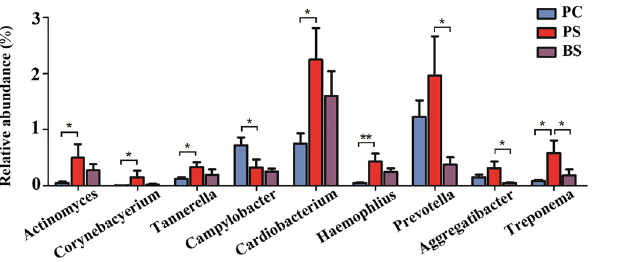
Fig 5. Comparisons of microbiota that presented significantly different contents in dental plaque of the black stain group (PS) and control group (PC) and black stain (BS) at genus level. * P < 0.05; ** P < 0.01.